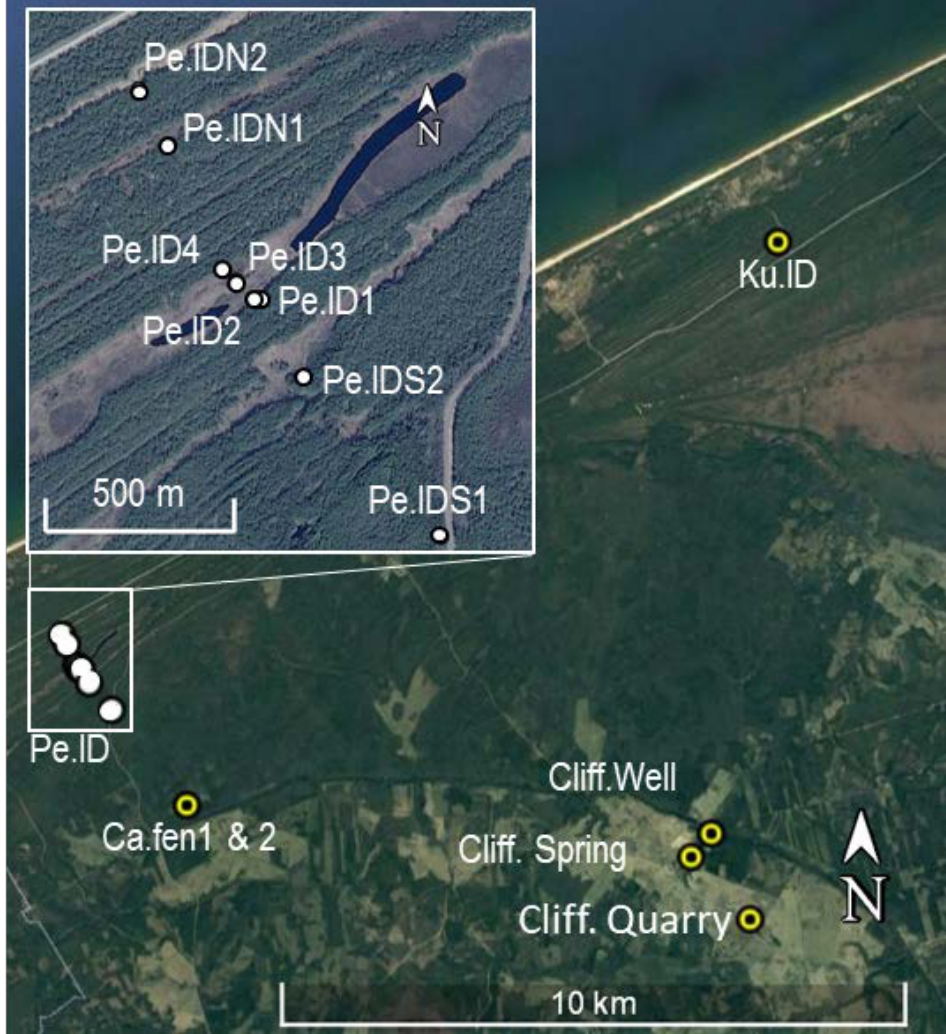
Figure 2. Water sampling sites in Slitere National